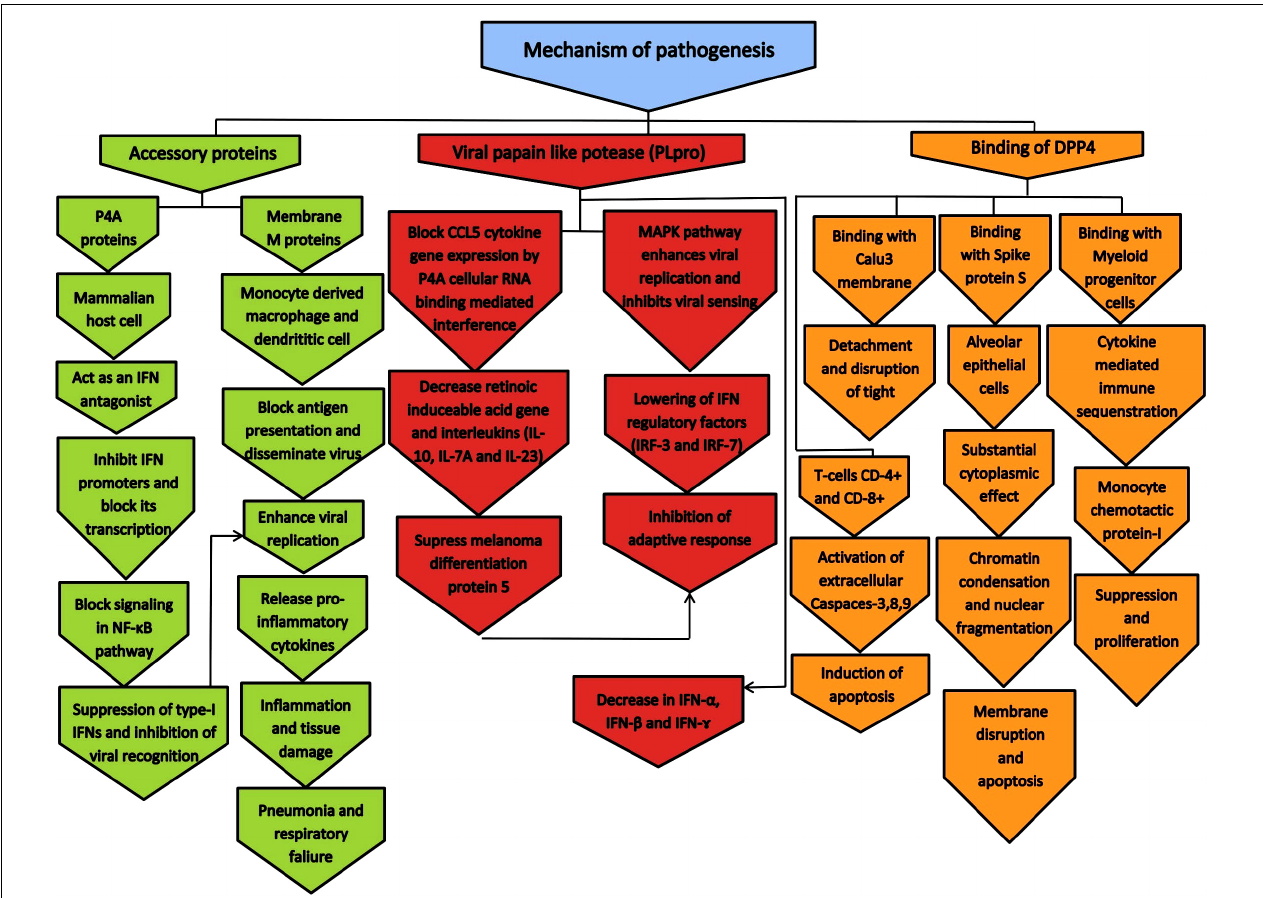
FIGURE 4 | The molecular mechanism of pathogenesis by MERS-CoV in human and animals. The pathogenesis mechanism is mainly occurred by DPP4, papian like protease PLpro, and accessory proteins such as p4a and membrane M protein (Durai et al., 2015).